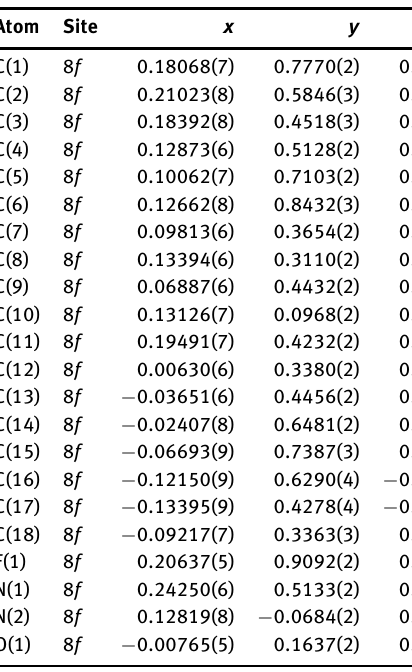
Table 3: Fractional coordinates and atomic displacement parameters (Å 2